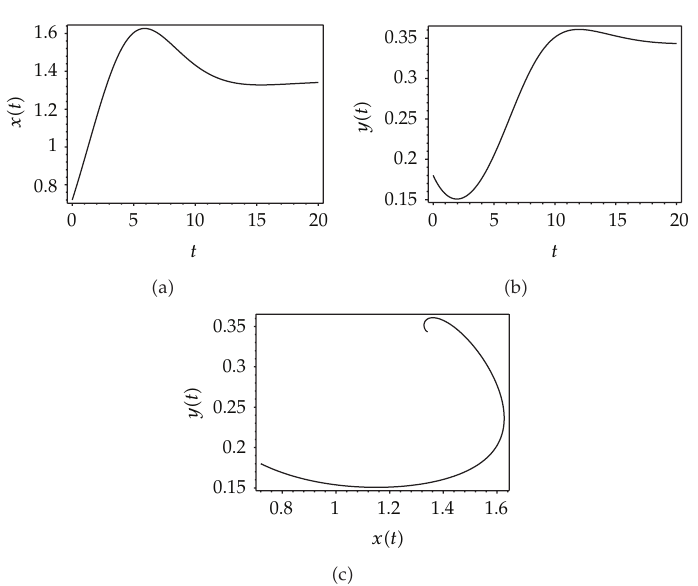
Figure 7: Time series and portrait phase of system (cid:6) 1.3 (cid:7) with p (cid:8) 0 . 4, q (cid:8) 0 . 5, x 0 (cid:8) 0 . 72, y 0 (cid:8) 0 . 18, h (cid:8) 2 . 4 > x ∗ , and (cid:6) 1 − p (cid:7) h (cid:8) 1 . 44 > x ∗ .